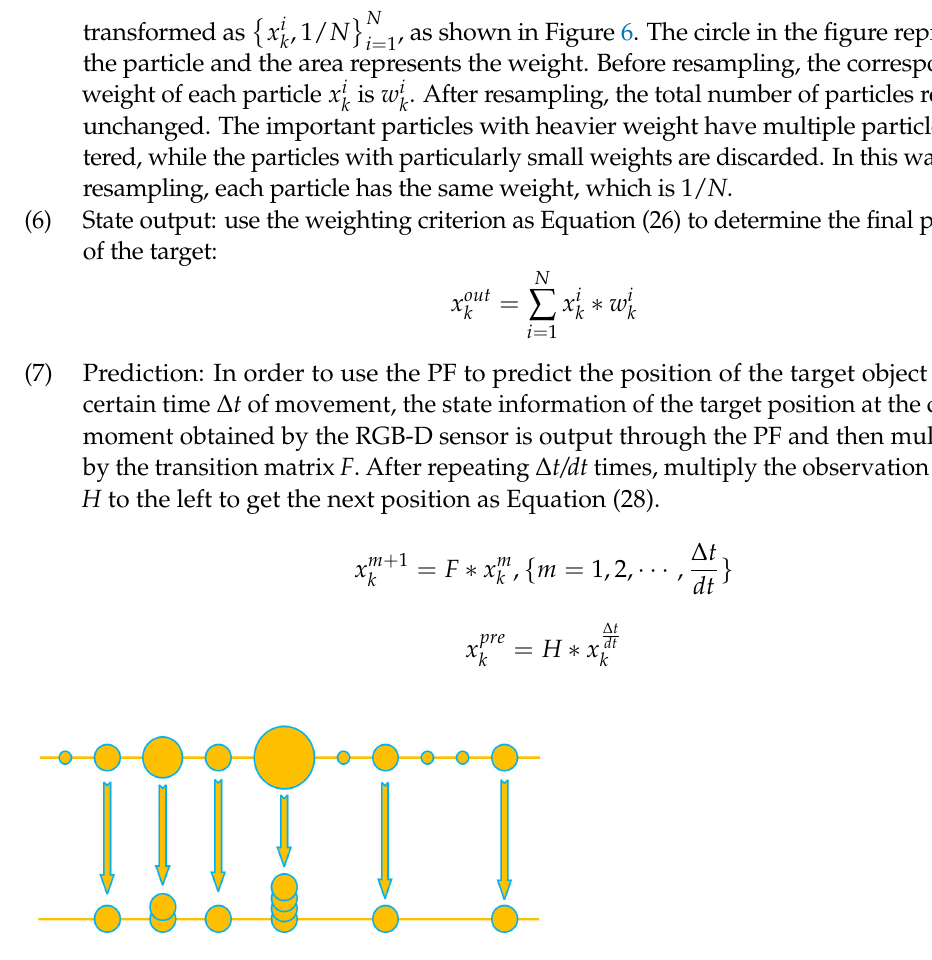
Figure 6. Resampling schematic diagram. According to the above initialization, the general process of state update, particle weight update, weight normalization, resampling, state output, and prediction are as shown in Figure 7. The overall target tracking and predicting algorithm based on PF is shown in Algorithm 1.